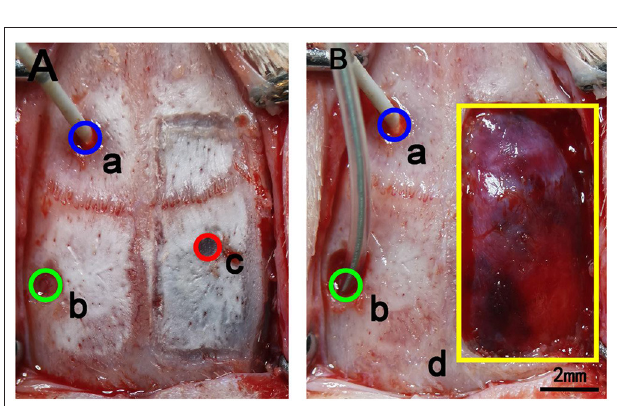
FIGURE 2 | Schematic diagram of the removal of bone flaps in rats. (A) a: The blue circle marks the area where the intracranial pressure probe was inserted through a craniotomy. The center point is 1.5mm in front of the coronal suture and 1.5mm to the left of the sagittal suture, and the diameter of the circle is 2mm. b: The green circle marks the craniotomy for balloon placement. The central point is 2mm behind the coronal suture and 4mm to the left of the sagittal suture, and the diameter of the opening is 2mm. c: The red circle marks the site of the injected subdural hematoma. The central point is 1.5mm behind the coronal suture and 3mm to the right of the sagittal suture, and the diameter is 1.3mm. (B) The yellow rectangle shows the location of the bone window opened for hematoma removal. The size of the bone window was 10 × 5mm. In the figure, the bone window has been removed, but the dura is